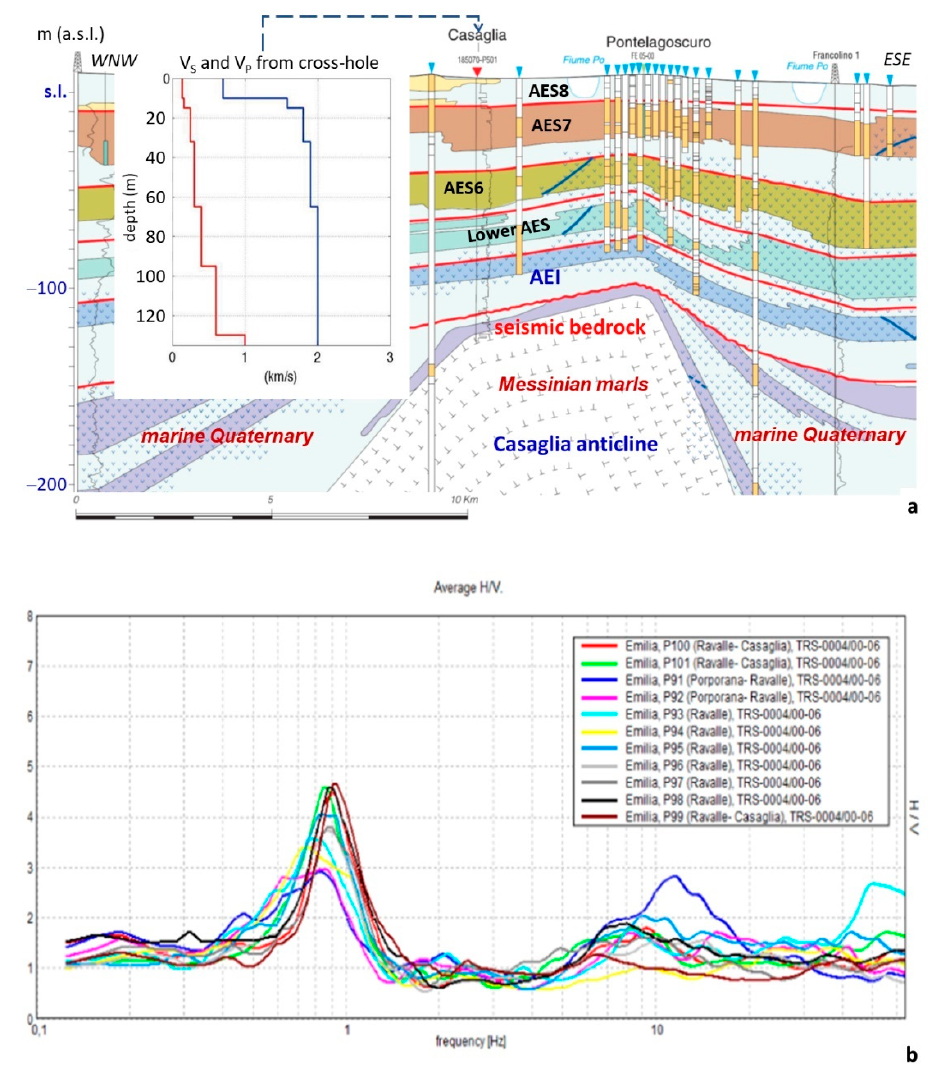
Figure 16. (a) Geological cross-section across the Mirandola anticline, ( b ) H/V spectral ratio and Vs profile from ambient vibration measurement (array) in the Mirandola urban area [19].